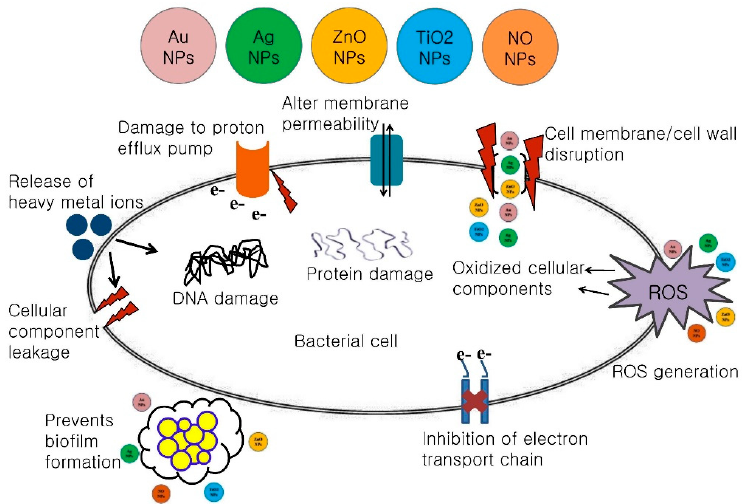
Figure 1. Schematic representations of the antimicrobial mechanisms of various nanoparticles (NPs).